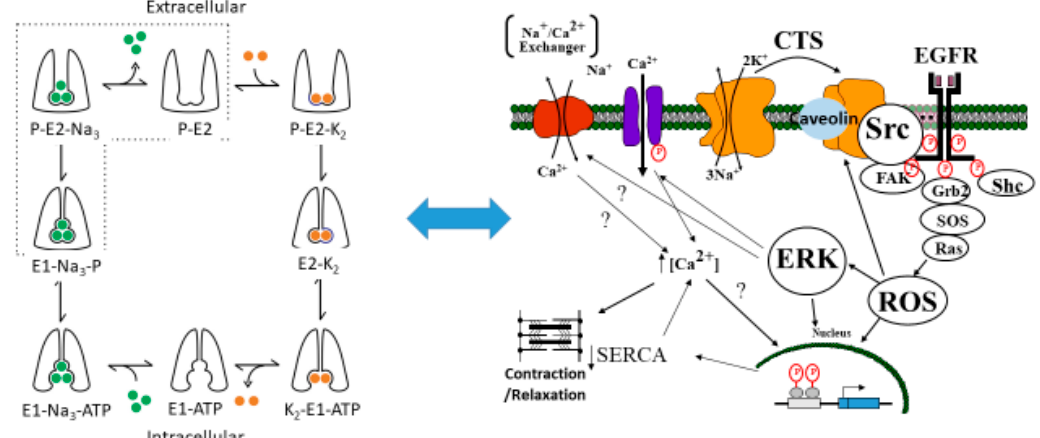
Figure 1. The proposed relationship between the Post-Albers model for the Na/K-ATPase ( left panel ) and signal transduction through caveolar Na/K-ATPase-Src-EGFR cascade. The Post-Albers model shows putative transitions between E1 and E2 states, as well as ion trafficking. Note that, according to this model, the Na/K-ATPase in the E1 state releases two K molecules in the cytosol, picks up three Na molecules, and is phosphorylated. It then coverts to the E2 state where the Na molecules are released into the extracellular space and two K molecules are picked up from this extracellular space, ultimately to be released into the cytoplasm as the cycle repeats. The right panel shows signal transduction through Src, the epidermal growth factor receptor (EGFR), and other signaling partners, including src homology 2-containing protein (Shc), growth factor receptor 2 (Grb2), and focal adhesion kinase (FAK), leading to son of sevenless (SOS) and Ras activation, which ultimately results in ROS generation which feeds back to the Na/K-ATPase. This putative schema discussed in several reviews [10–12].